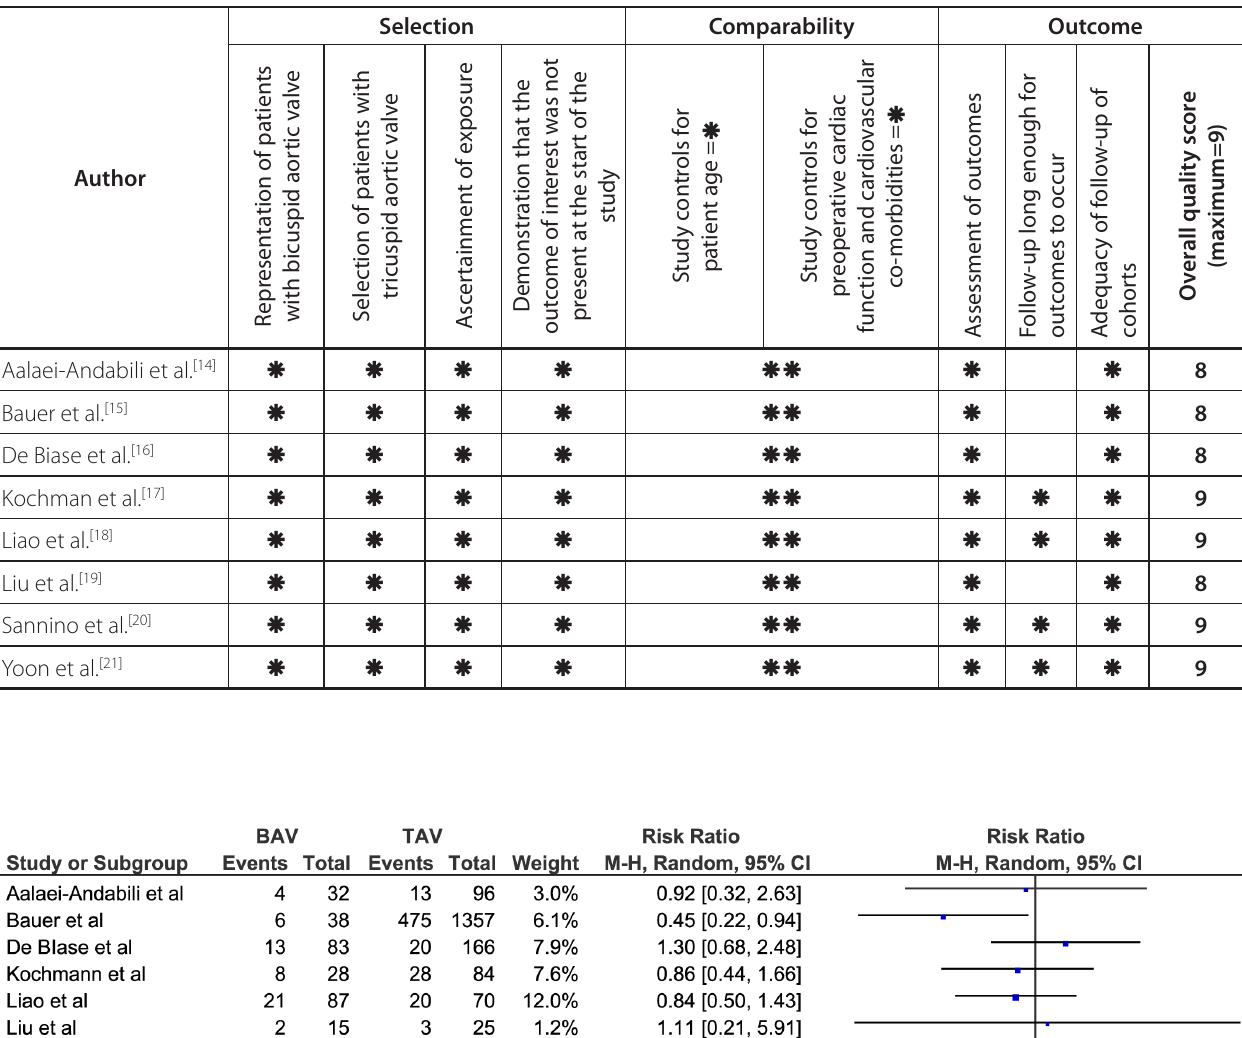
Table 2 . Newcastle-Ottawa Scale.